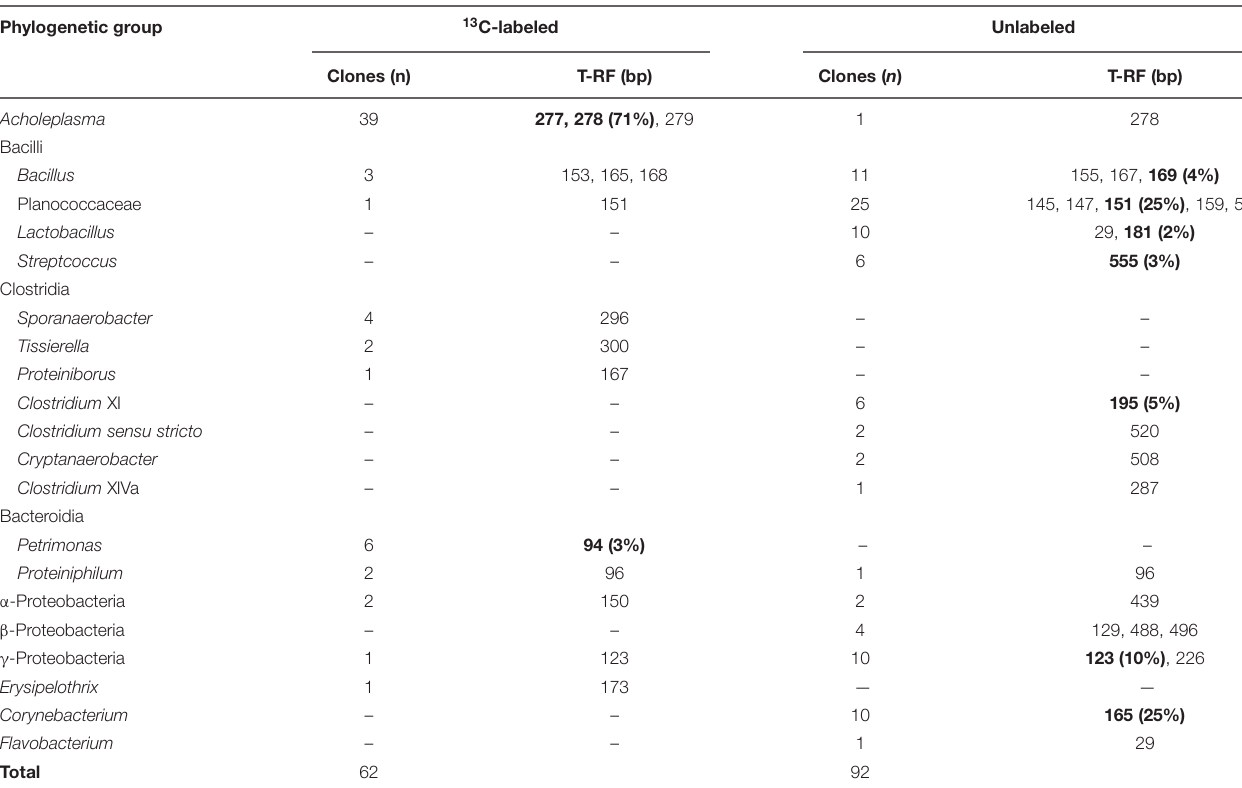
TABLE 1 | Phylogenic affiliations, T-RF length, and number of 16S rRNA clones obtained from the highest-density fraction of bacterial RNA following addition of 13 C-labeled and unlabeled bacterial biomass. Phylogenetic